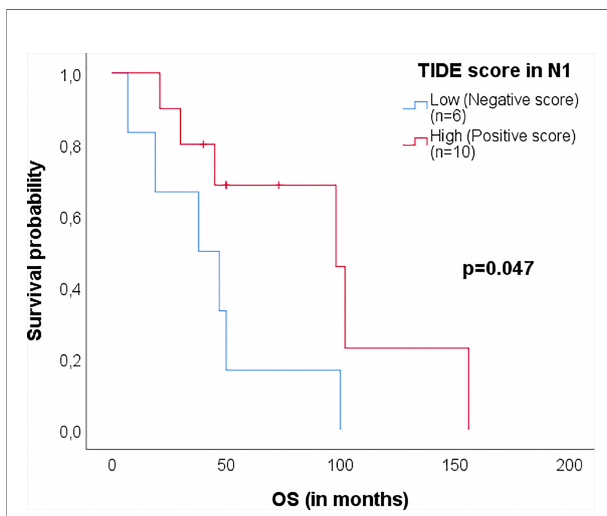
FIGURE 1 | Kaplan-Meier survival plot of patients with TIDE High/Low for OS in N1 ntbLNs. TIDE Low tissues showed negative TIDE values, indicating the presence of immune evasion markers. TIDE High tissues showed positive TIDE values, indicating a lack of immune evasion. P-values were obtained from log-rank